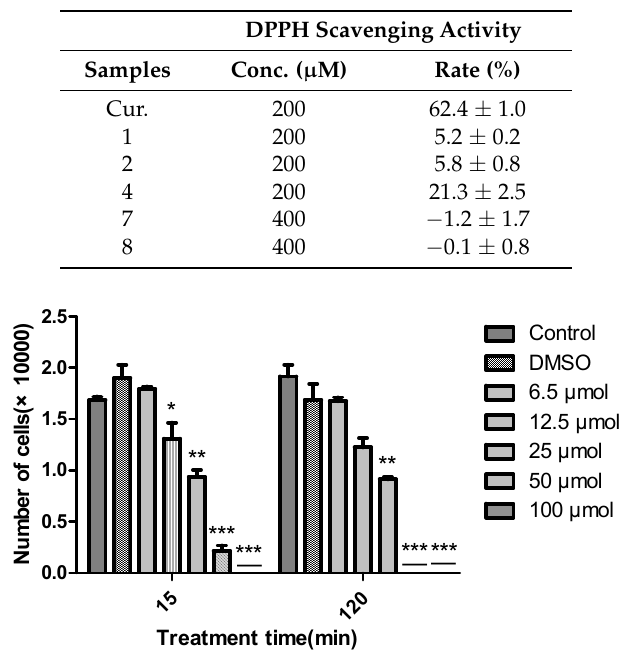
Table 2. DPPH radical scavenging activity (%) of isolated compounds and curcumin (Cur., positive control).